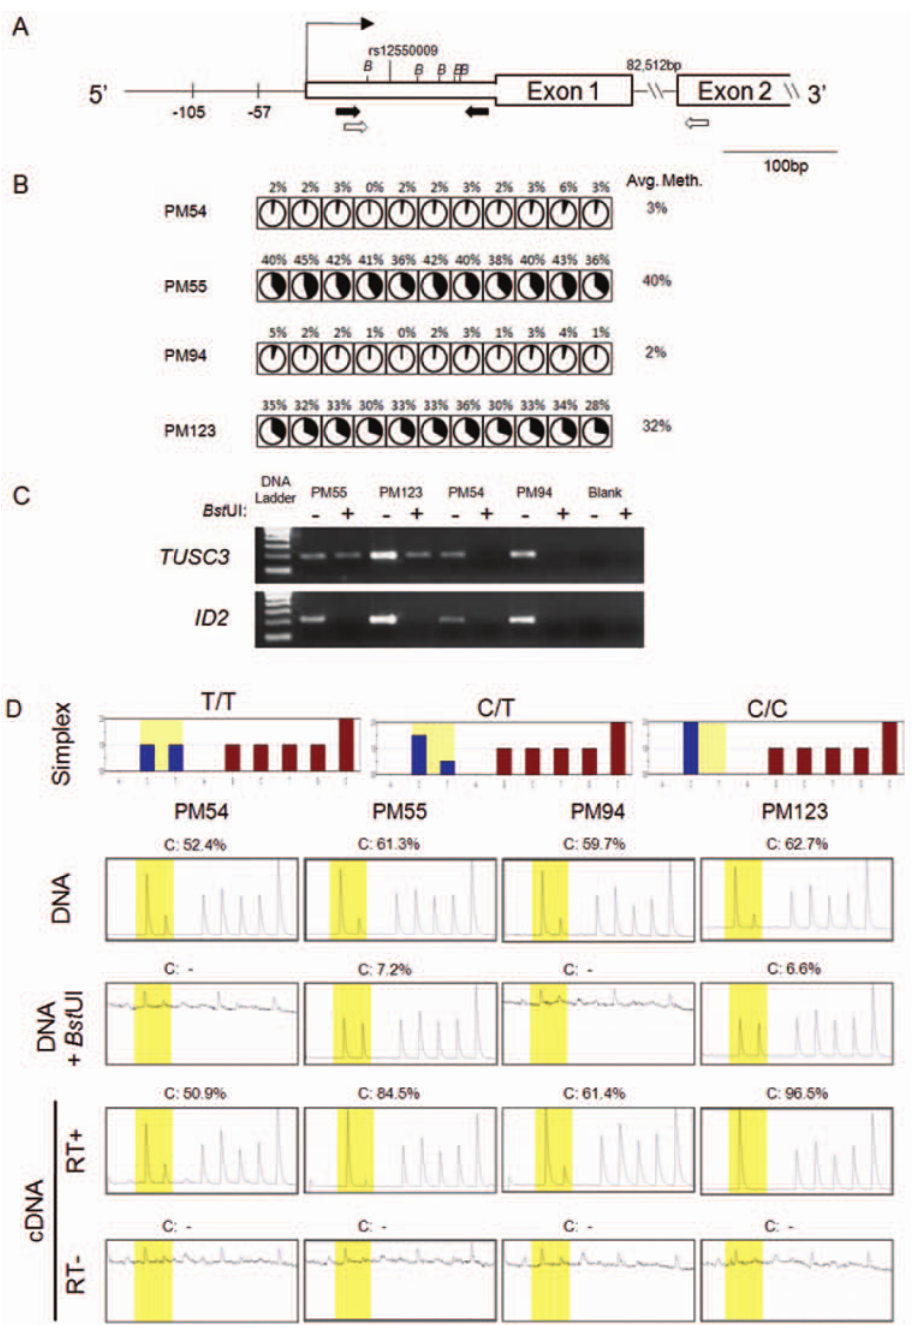
Figure 4. Promoter CpG methylation correlates with lack of TUSC3 gene expression. (A) Schematic of TUSC3 locus showing the regions investigated by bisulfite pyrosequencing on the promoter ( 2 105 to 2 57 relative to the transcriptional start site according to NM_006765) and genotyping assays of the 5 9 untranslated region. PCR primers for DNA genotyping are indicated by black arrows while RT-PCR primers for mRNA genotyping are indicated by arrows highlighted in white. Enzyme recognition sites for Bst UI are indicated by ‘‘ B ’’. (B) Methylation status of TUSC3 promoter region studied by bisulfite pyrosequencing. A similar methylation level of every CpG within each sample is observed and the gene follows ‘‘on-or-off’’ methylation pattern. Each circle represents a CpG site in a sample. Area shaded in black is proportional to the methylation level of the CpG site indicated by pyrosequencing. (C) Validation of complete methylation-sensitive restriction enzyme digestion on unmethylated molecules. Genomic DNA was predigested with Bst UI followed by PCR amplification with TUSC3 and ID2 specific primers (Table S2). Bst UI digestion sites within the ID2 region were unmethylated (Figure S6) and, therefore, no PCR product was generated after enzyme digestion. (D) Allele-specific methylation of TUSC3 on the fragment containing SNP rs12550009 demonstrated by enzyme digestion pyrosequencing. The ‘‘Simplex’’ diagrams (top) show the reference pyrograms by genotype. A heterozygous CT in the methylated samples (PM55 and PM123) displays a homozygous T pattern after Bst UI digestion indicating predominant methylation of the T allele. Allele-specific mRNA expression is concordant with allele-specific methylation on the same SNP rs1250009. Predominant expression of C alleles was observed in the cDNAs generated by RNA specific primers (bottom). RT + and RT 2 represent assays with Reverse Transcriptase and without Reverse Transcriptase, respectively.